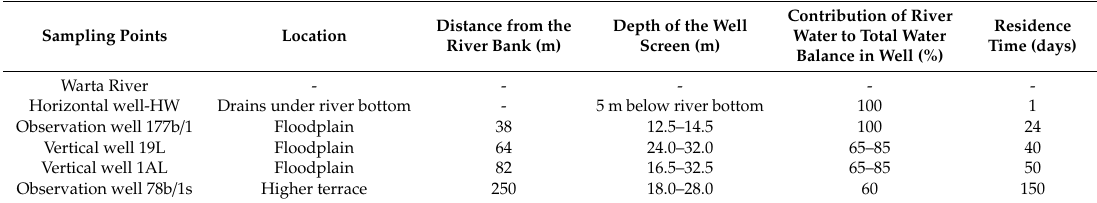
Table 1. Characterization of sampling points.